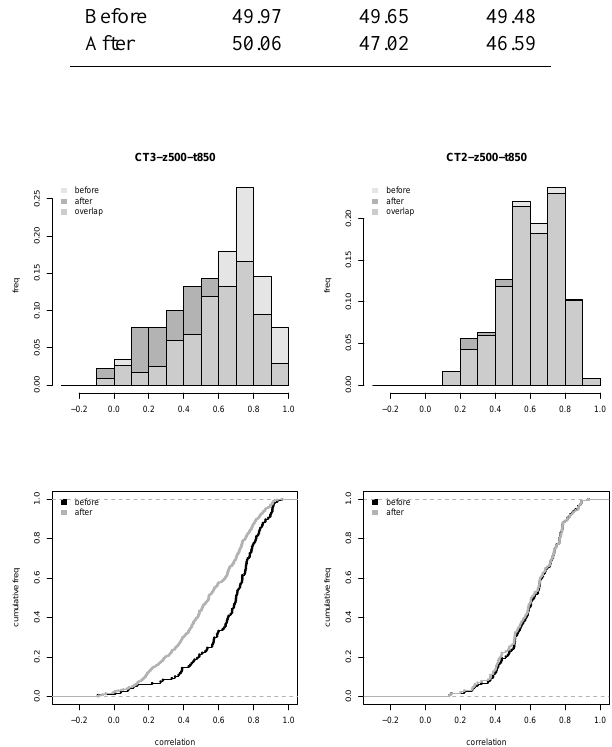
Figure 6. Histograms and empirical cumulative distribution func- tions of the correlations for CT3 of Z500–T850 (left) and CT2 of Z500–T850 (right). Each panel shows the populations before and after the allocation